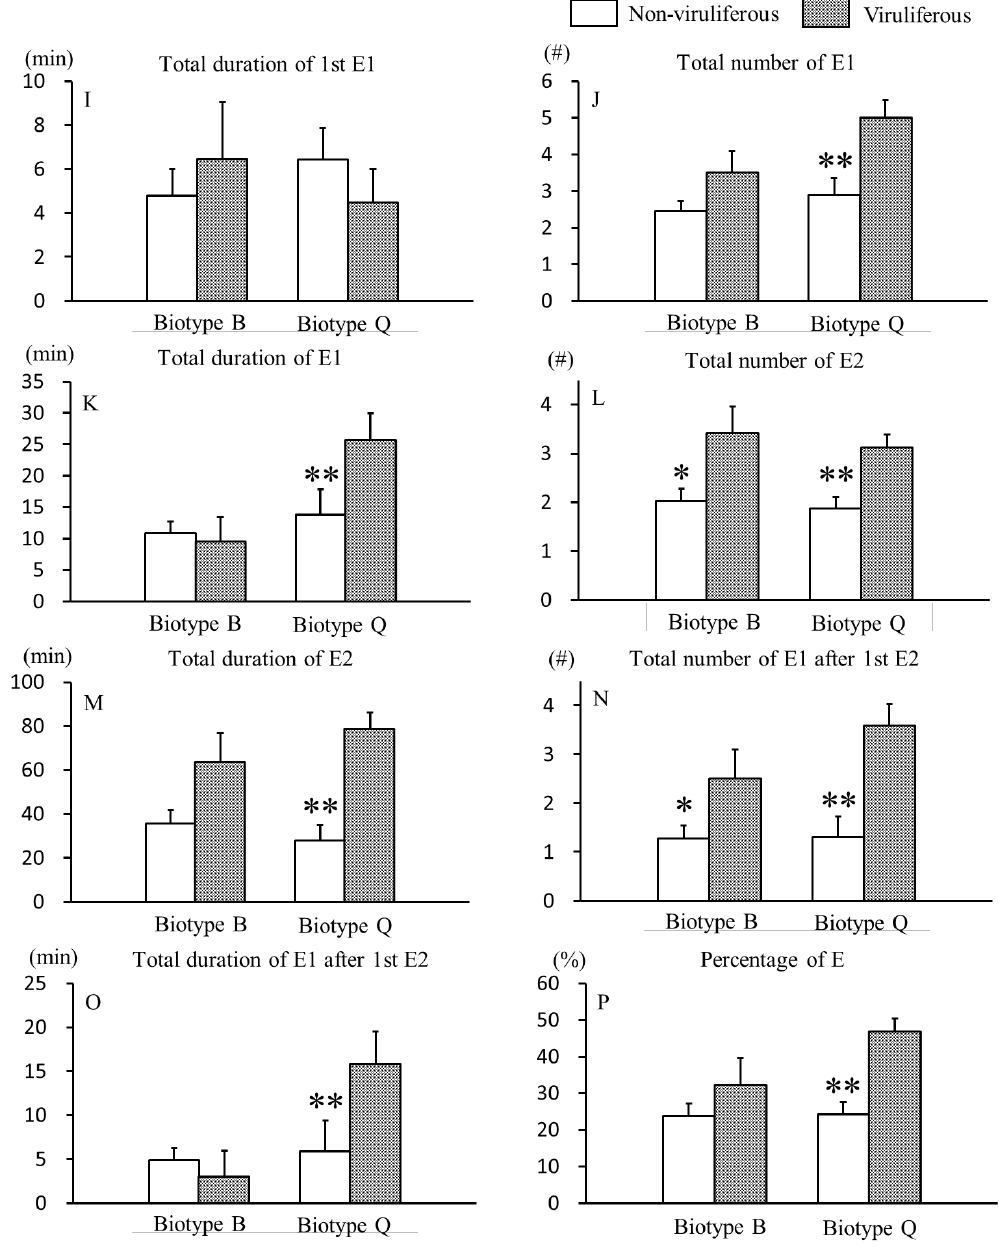
Figure 2. Phloem EPG variables of B. tabaci B and Q biotypes with CCYV. Date represent means ± SE; bars with asterisk(s) (* or **) indicate a statistically significant difference between the non-viruliferous and viruliferous whiteflies of same biotype at p < 0.05 or p < 0.01 (Mann-Whitney test); percentage of E (%) = percentage of total duration of E (E1 + E2) in the recording time. EPG waveforms: E1 = phloem salivary secretion; E2 = phloem sap ingestion.